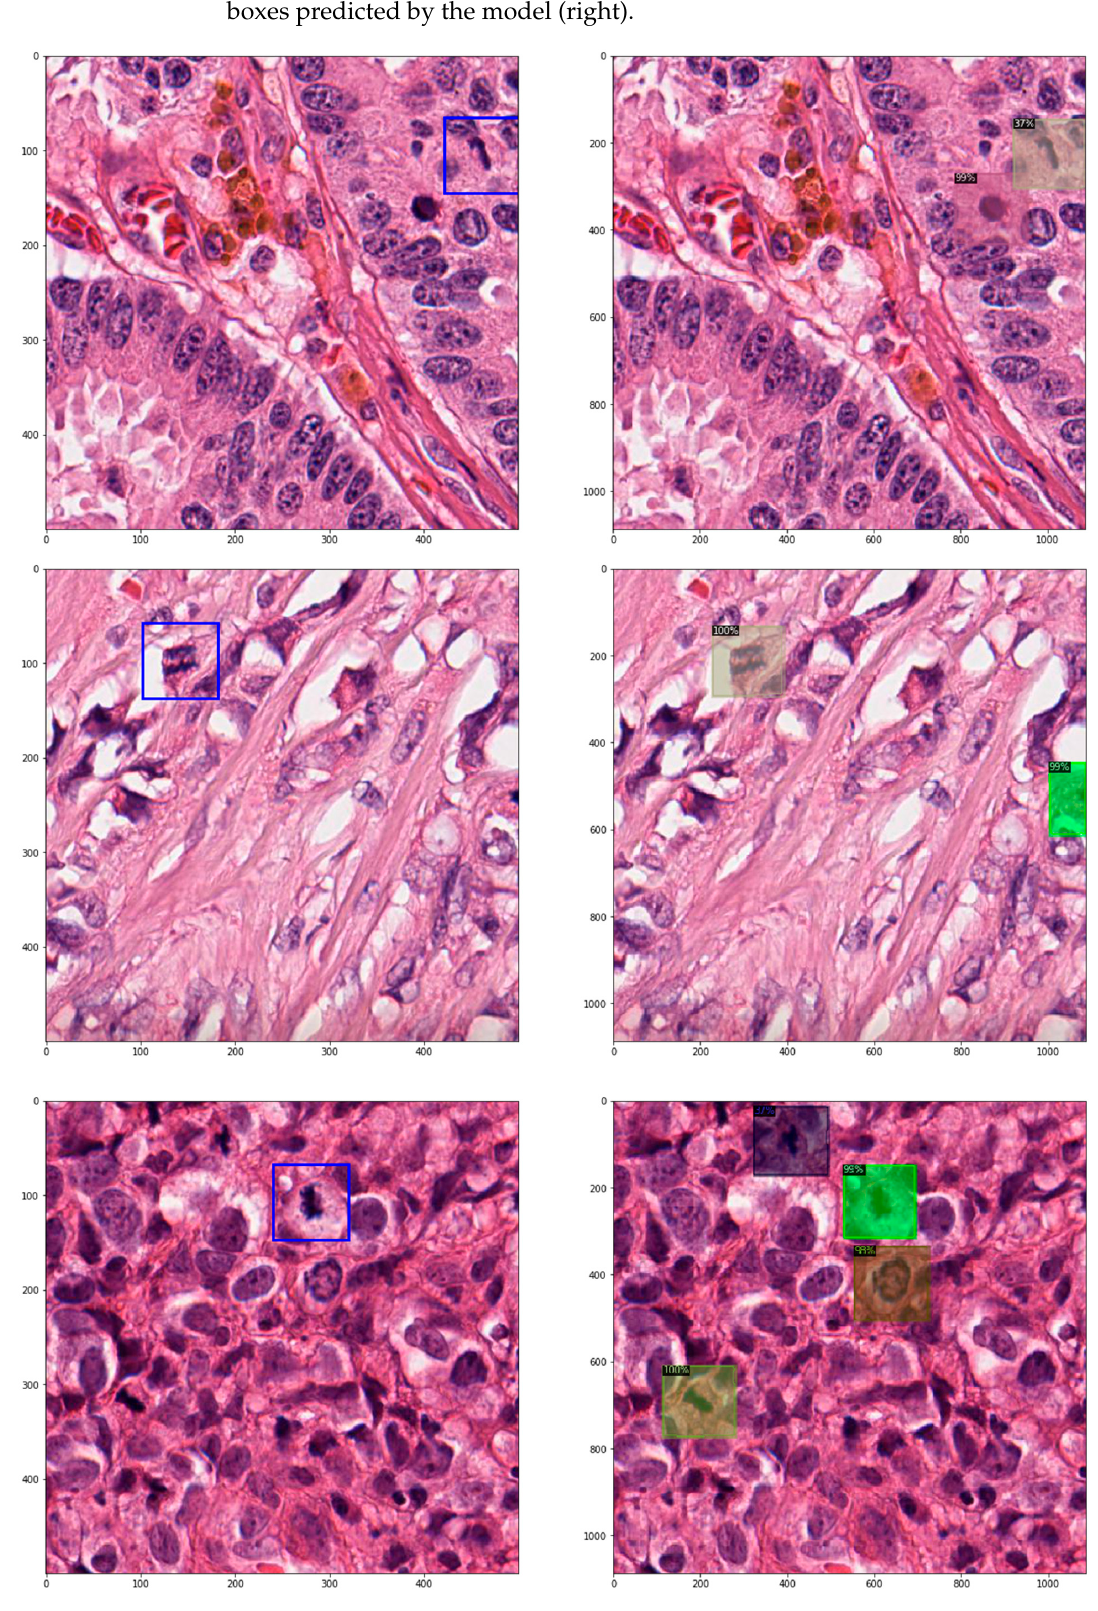
Figure 1. Sample WSIs from the test set with annotated ground truth ( left ) and predictions ( right